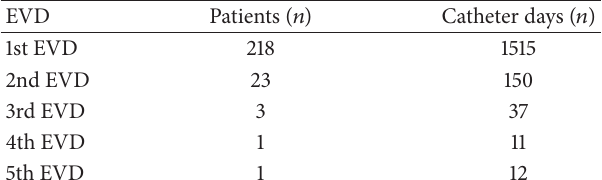
Table 1: EVD catheter data.